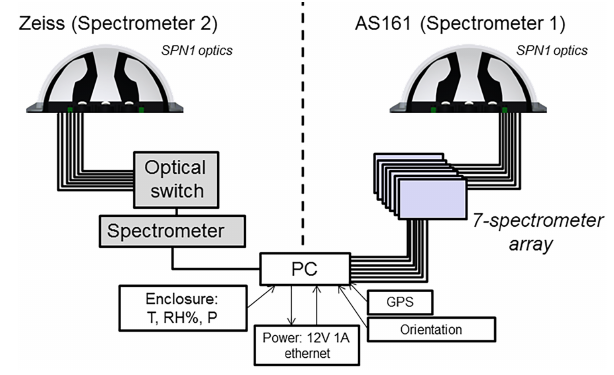
Figure 2. System diagram for the two spectrometer configurations. Elements in white are common to both configurations, although each have their own separate PC, GPS, etc. The main configura- tional difference is that AS161 (Spectrometer 1) contains seven spectrometers, whereas Zeiss (Spectrometer 2) contains only one which is connected to the seven optical channels via an optical switch. The PC enclosure temperature ( T ), relative humidity (RH) and atmospheric pressure ( P ) is